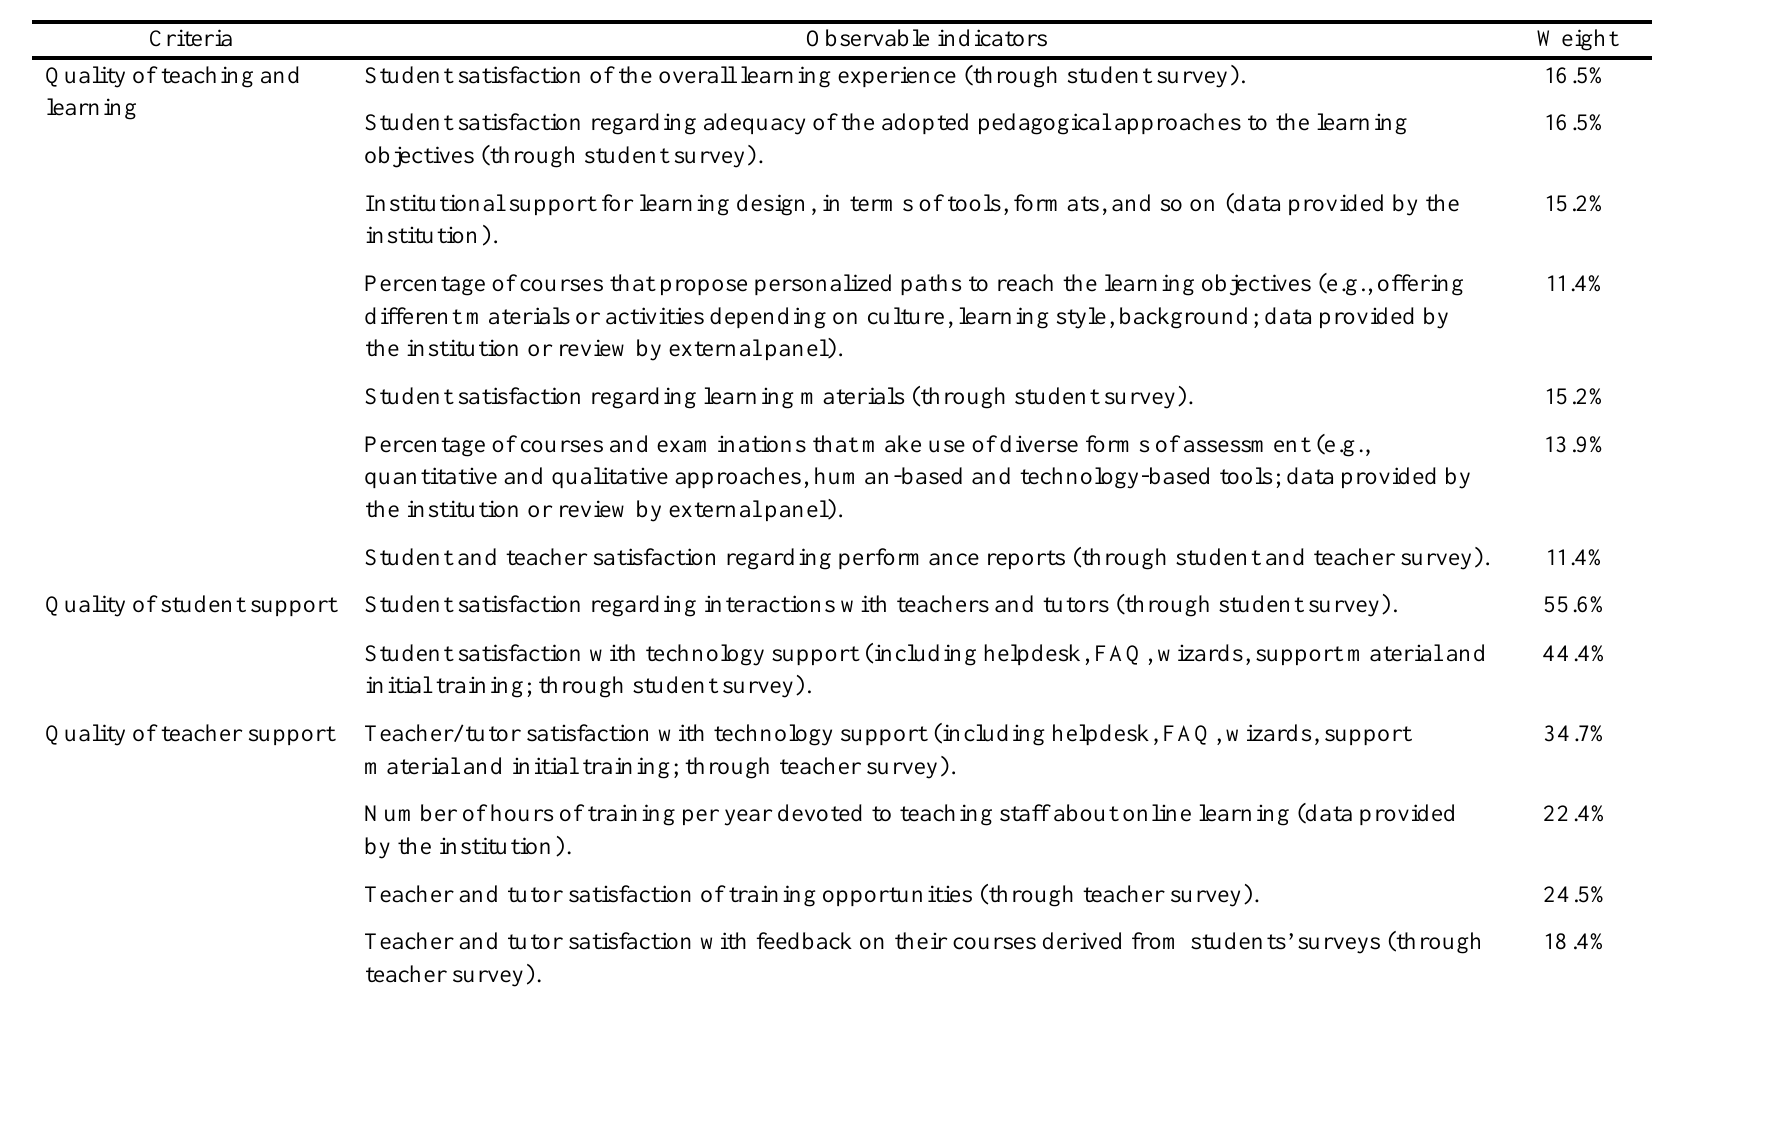
Complete List of Criteria, Observable Indicators, and Weights (Outcome of Round